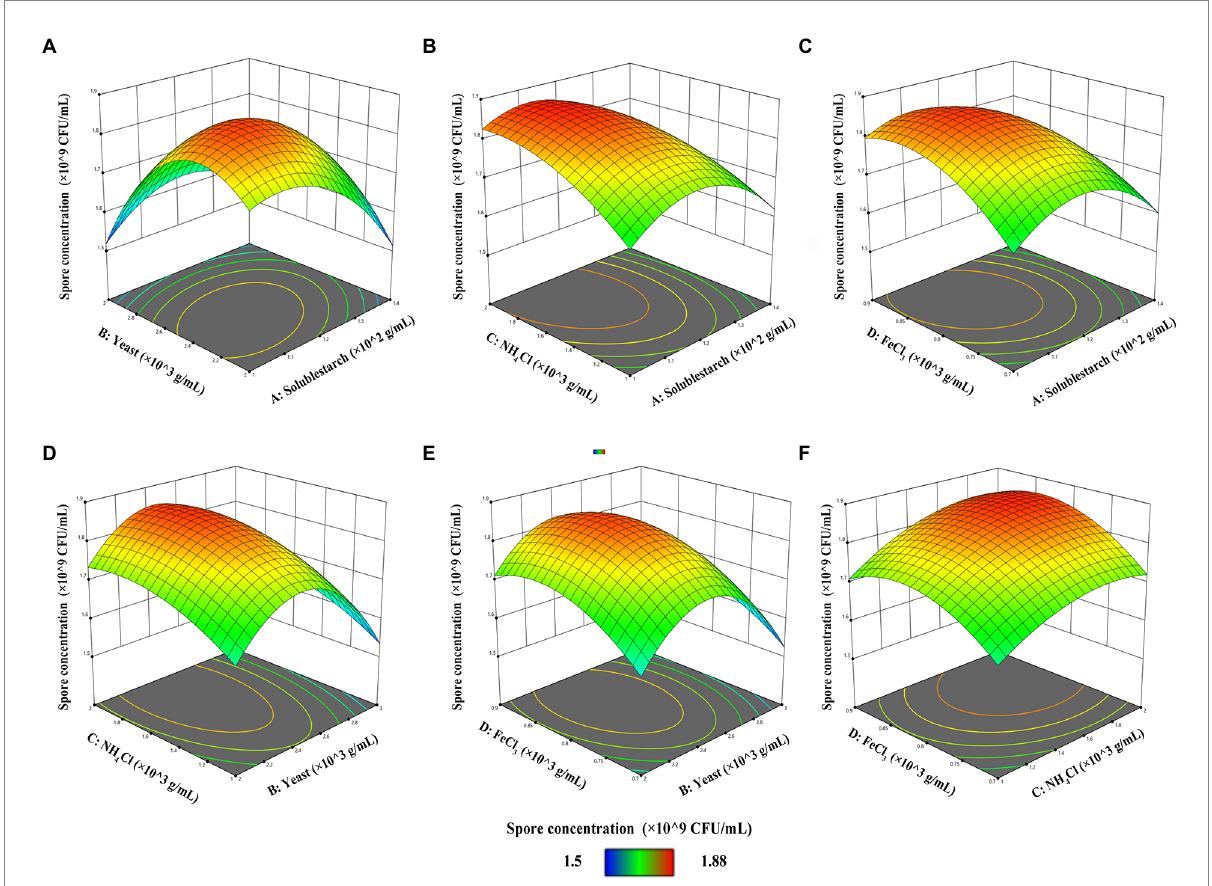
FIGURE 3 Three-dimensional contour plots of RSM for combined effects of (A) soluble starch and yeast, (B) soluble starch and NH 4 Cl, (C) soluble starch and FeCl 3 , (D) yeast and NH 4 Cl, (E) yeast and NH 4 Cl, and (F) yeast and FeCl 3 on FYN-22 spore concentration ( n =